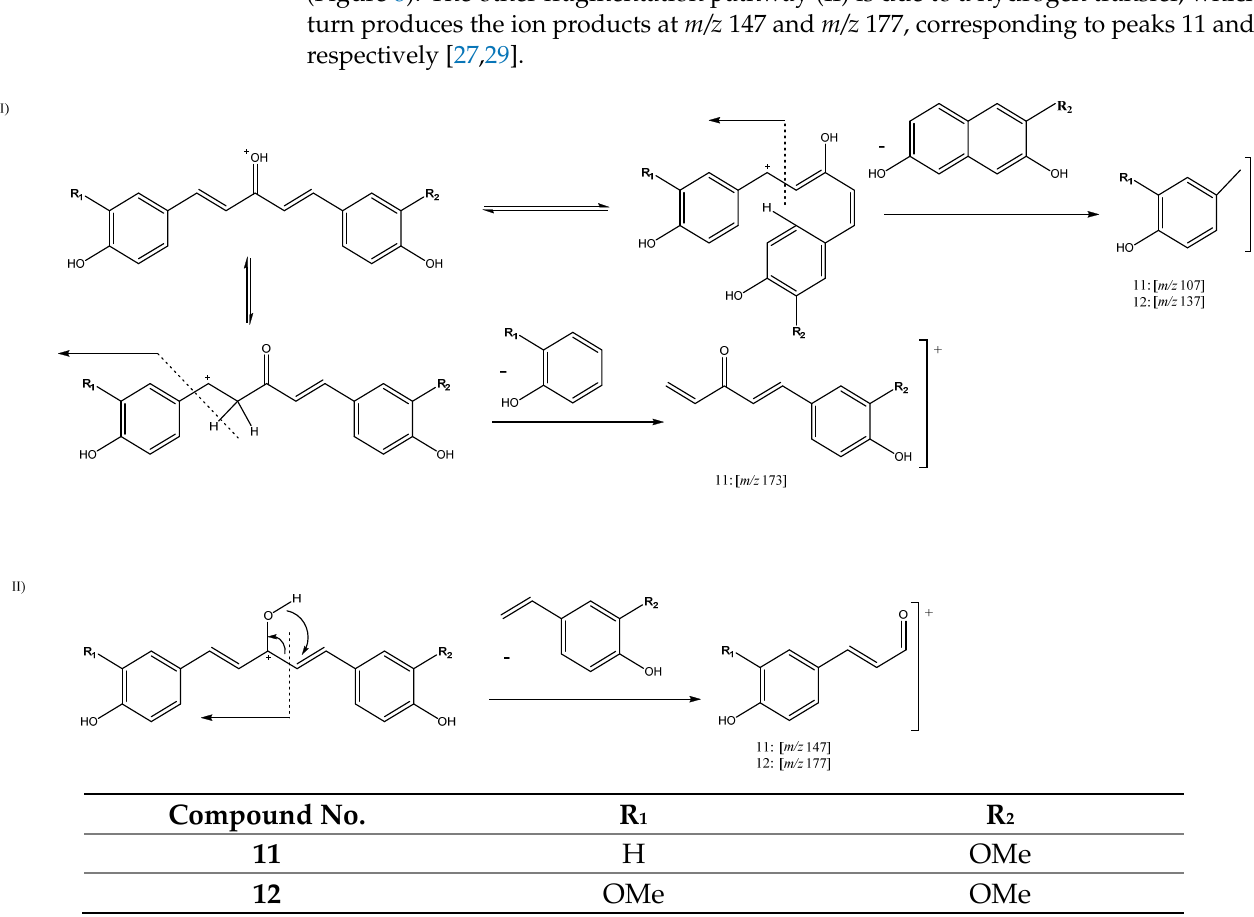
OMe Figure 7. Fragmentation pathway for peaks 2 , 26 and 29 . Peaks 11 (Rt = 13.52 min) and 12 (Rt = 13.97 min) also pertain to this group of curcu-